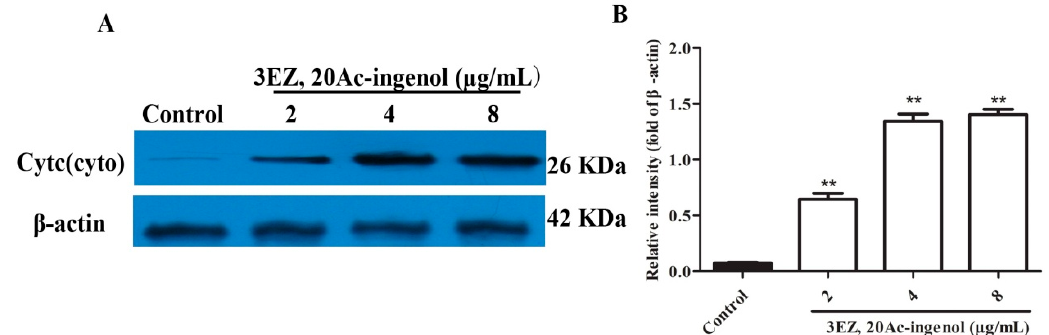
Figure 7. The effects of 3EZ, 20Ac-ingenol on the expression of cytc (cyto). L-O2 cells were incubated with 2, 4 and 8 μ g/mL of 3EZ, 20Ac-ingenol for 48 h, and then cytc (cyto) was assessed via Western blotting ( A ). Quantification of cytc (cyto) was analyzed and expressed ( B ). Values are expressed as mean ± SD from three independent experiments, ** P < 0.01 compared with control group.